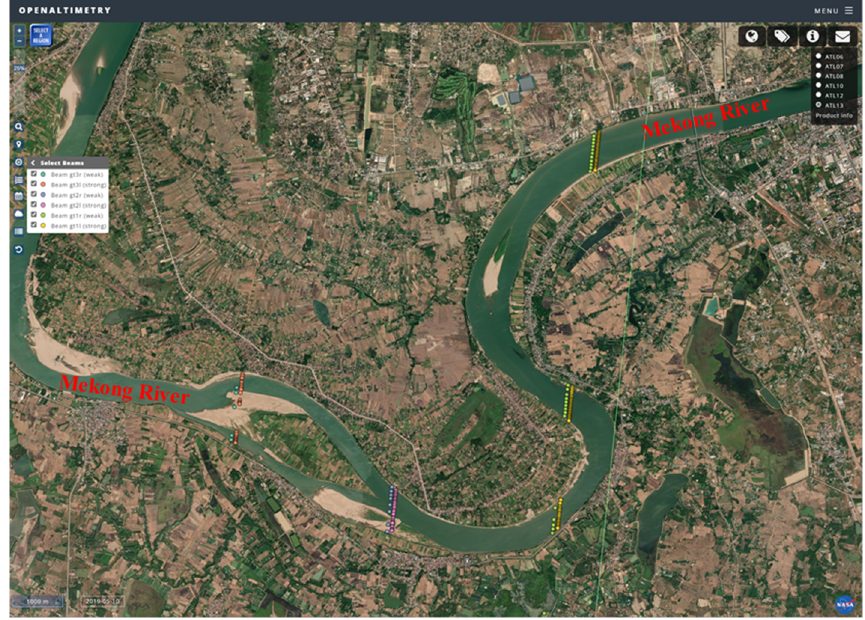
Figure 2. Ground track and six beams of ATL13 data covering the Mekong River. The image was derived from https://openaltimetry.org/data/icesat2/website (accessed on 17 December 2021).